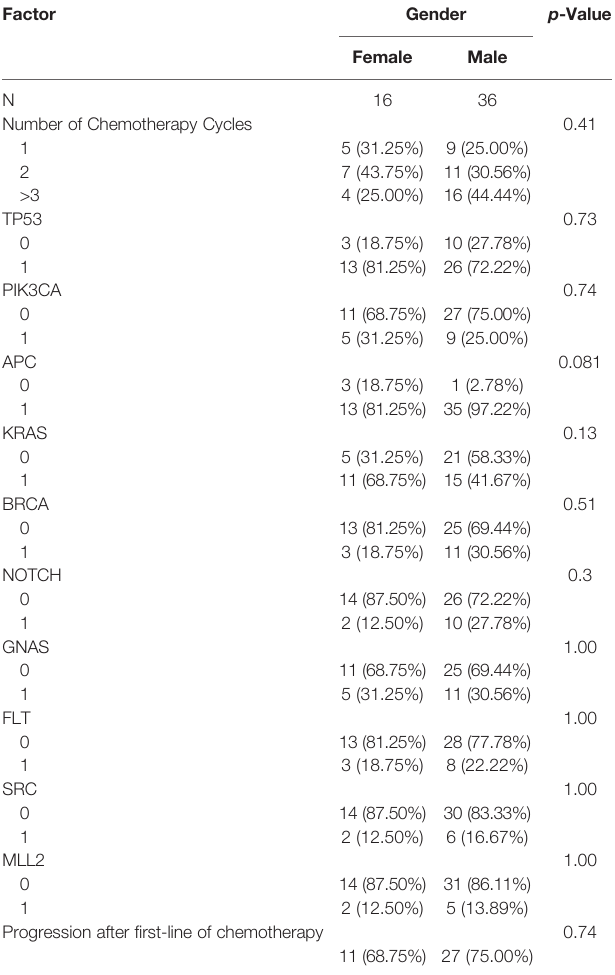
TABLE 3 | Comparison of mutated genes, treatments, and progression between genders. Factor